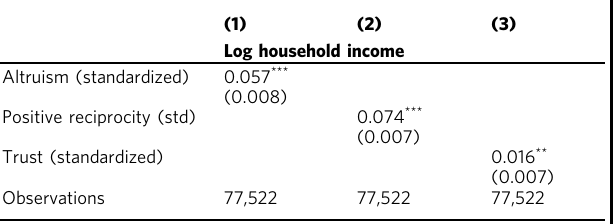
Table 3 Altruism, reciprocity and trust predicts labor market success.